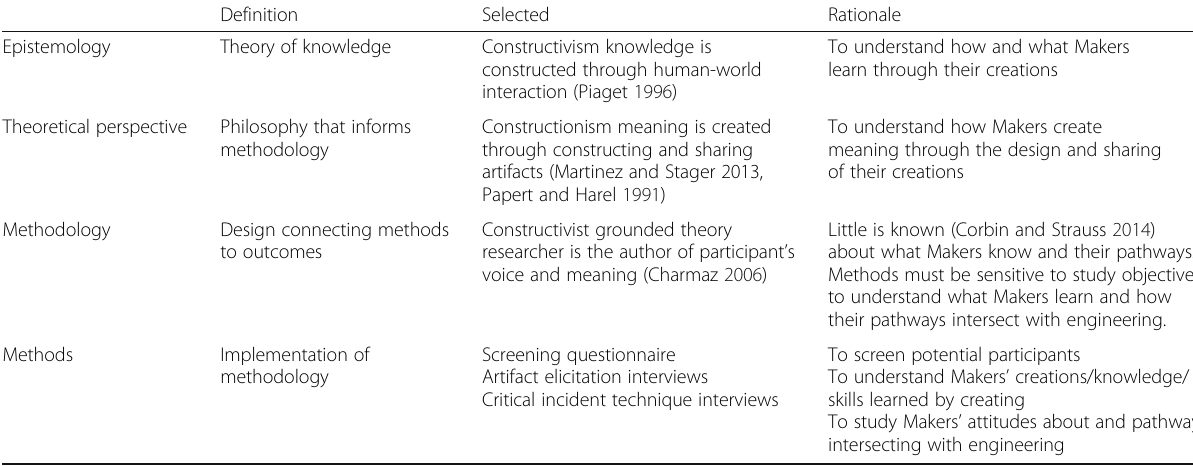
Table 1 Elements of a research study by Crotty